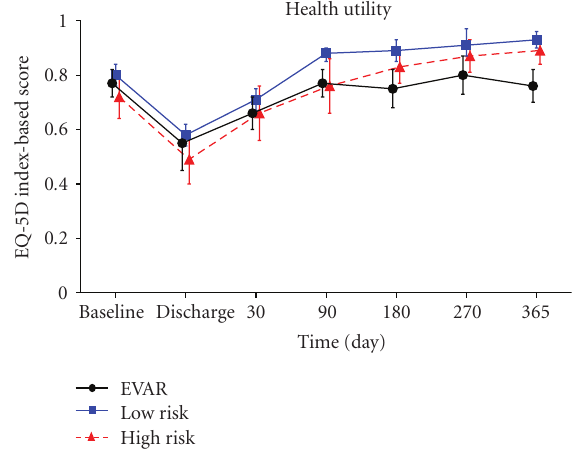
Figure 4: EQ-5D utility scores and confidence intervals.